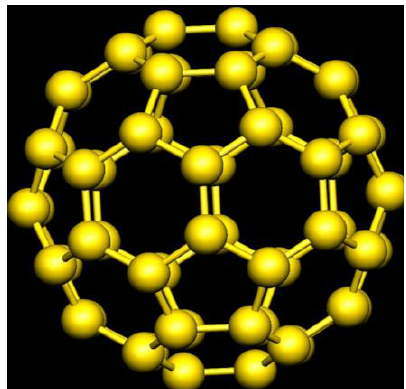
Figure 1. A buckminsterfullerene.